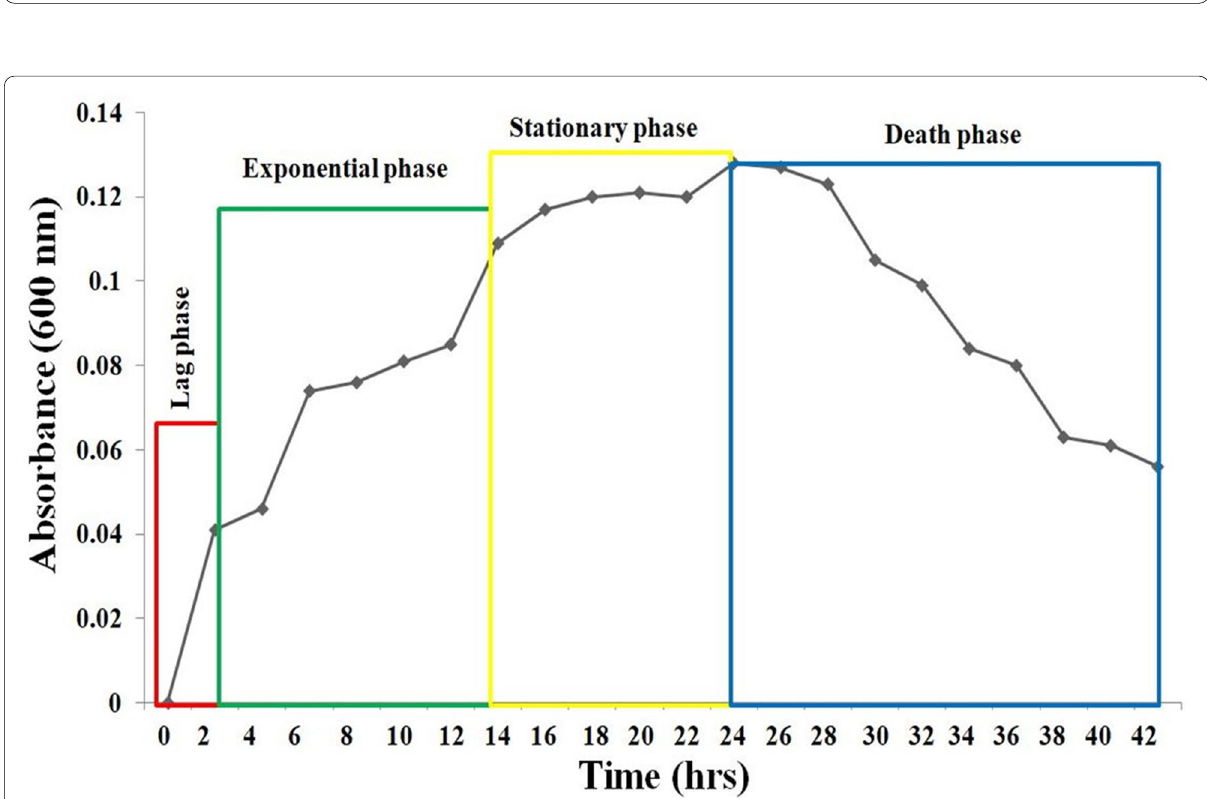
Fig. 3 Growth of the bacterium SLB10 in the culture flask containing MSM-L medium and the cuvettes showing the pattern of dye decolonization of methylene blue during LiP enzyme assay